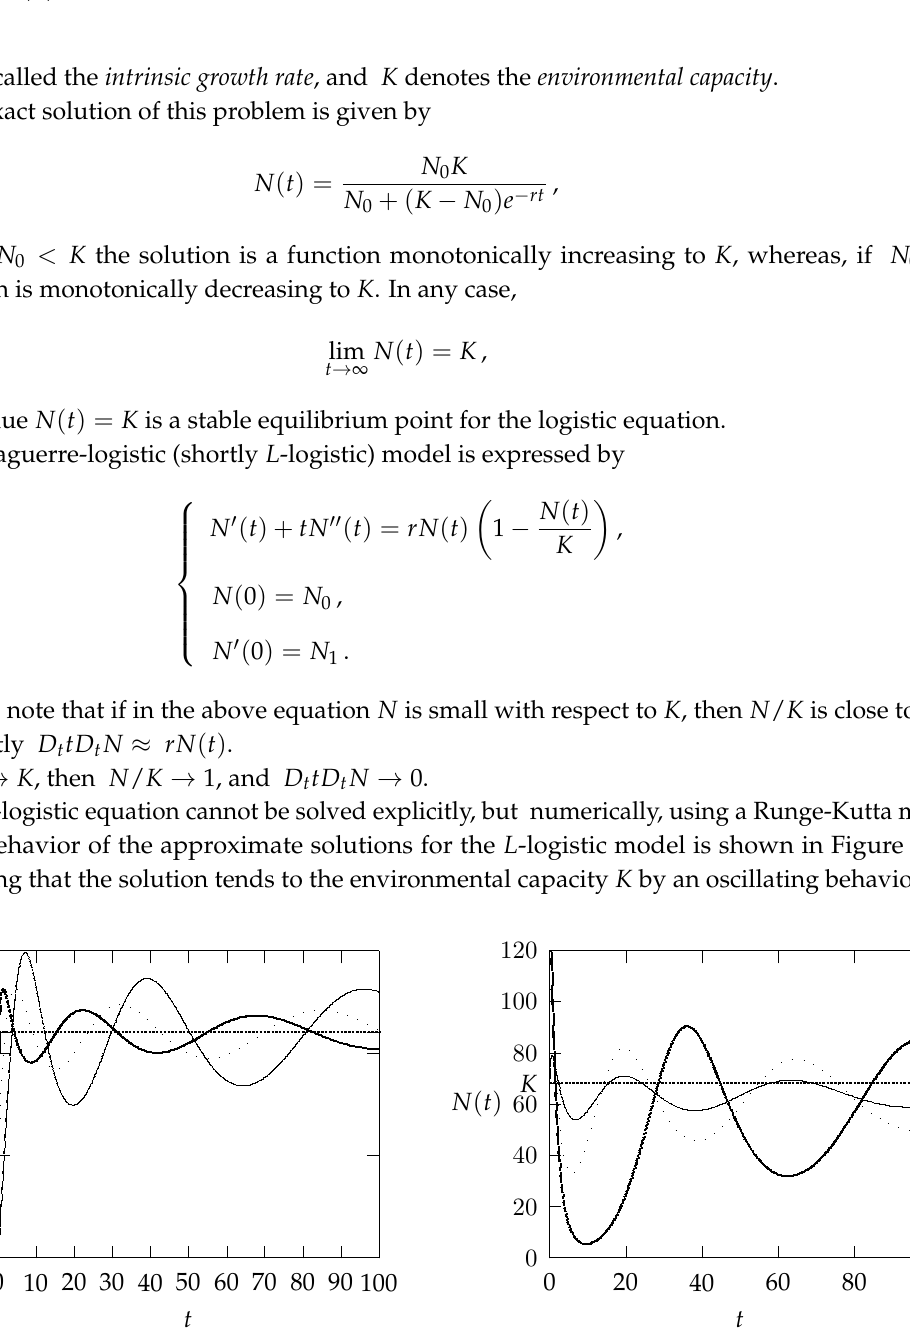
Figure 4. Solutions to the L -logistic model with N ( 0 ) = N (cid:48) ( 0 ) < K (on the left), N ( 0 ) = N (cid:48) ( 0 ) > K (on the right), K = 64, r = 0.8, T = 100, ∆ t =